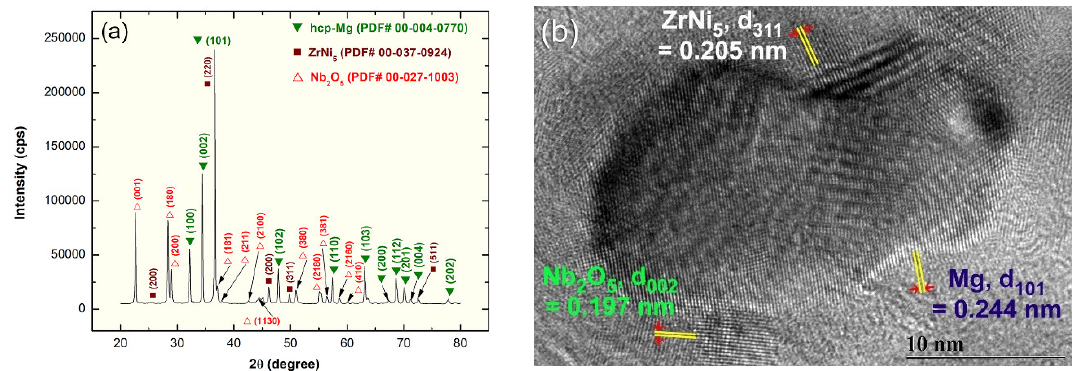
Figure 11. Secondary electron beam micrograph taken at 1 kV for MgH 2 /5 wt% (2.5 ZrNi 5 /2.5 Nb 2 O 5 ) powders after completion 228 cycles conducted at 200 °C.